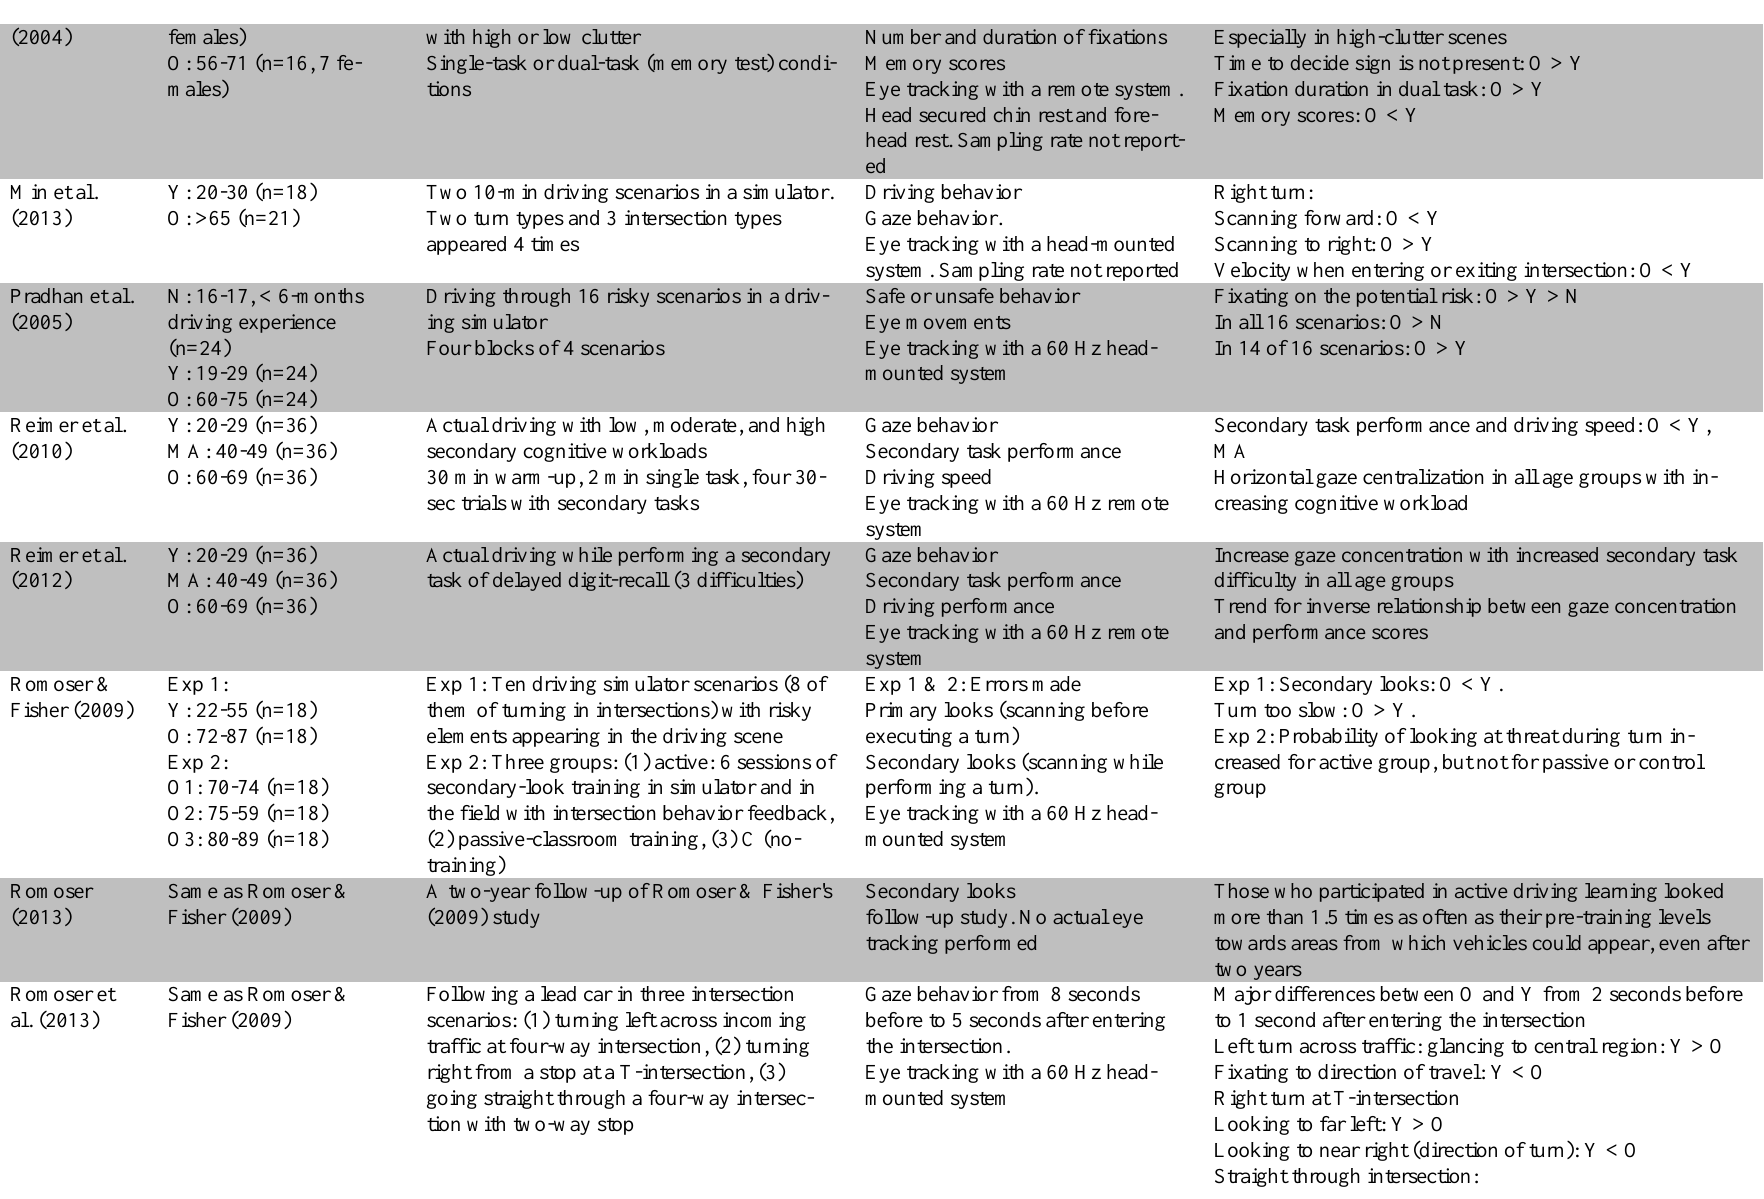
two years Major differences between O and Y from 2 seconds before Fixating to direction of travel: Y <